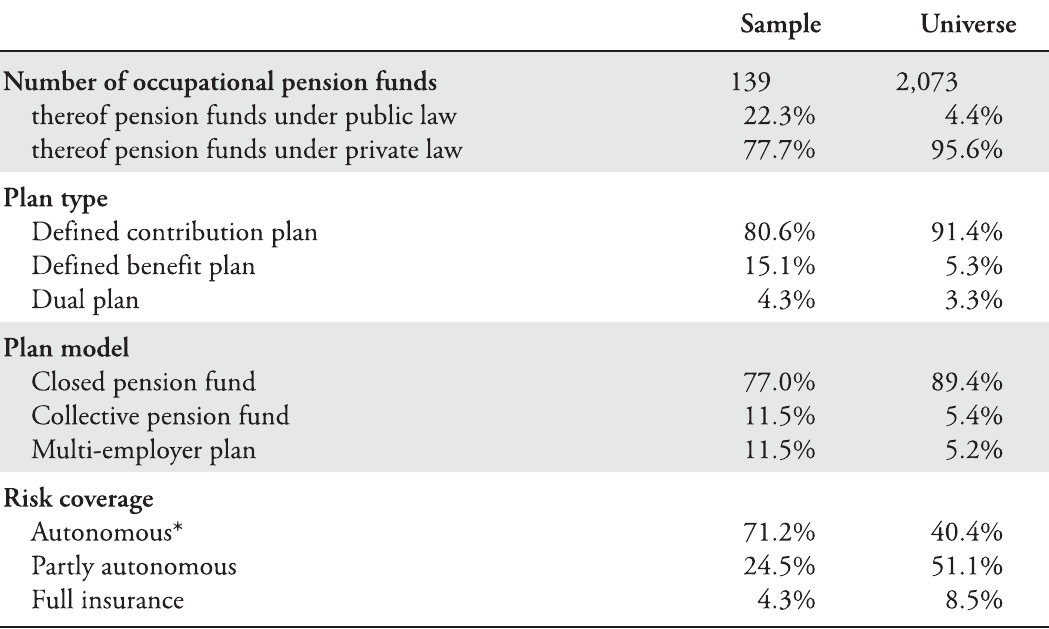
Table 7: Pension Fund